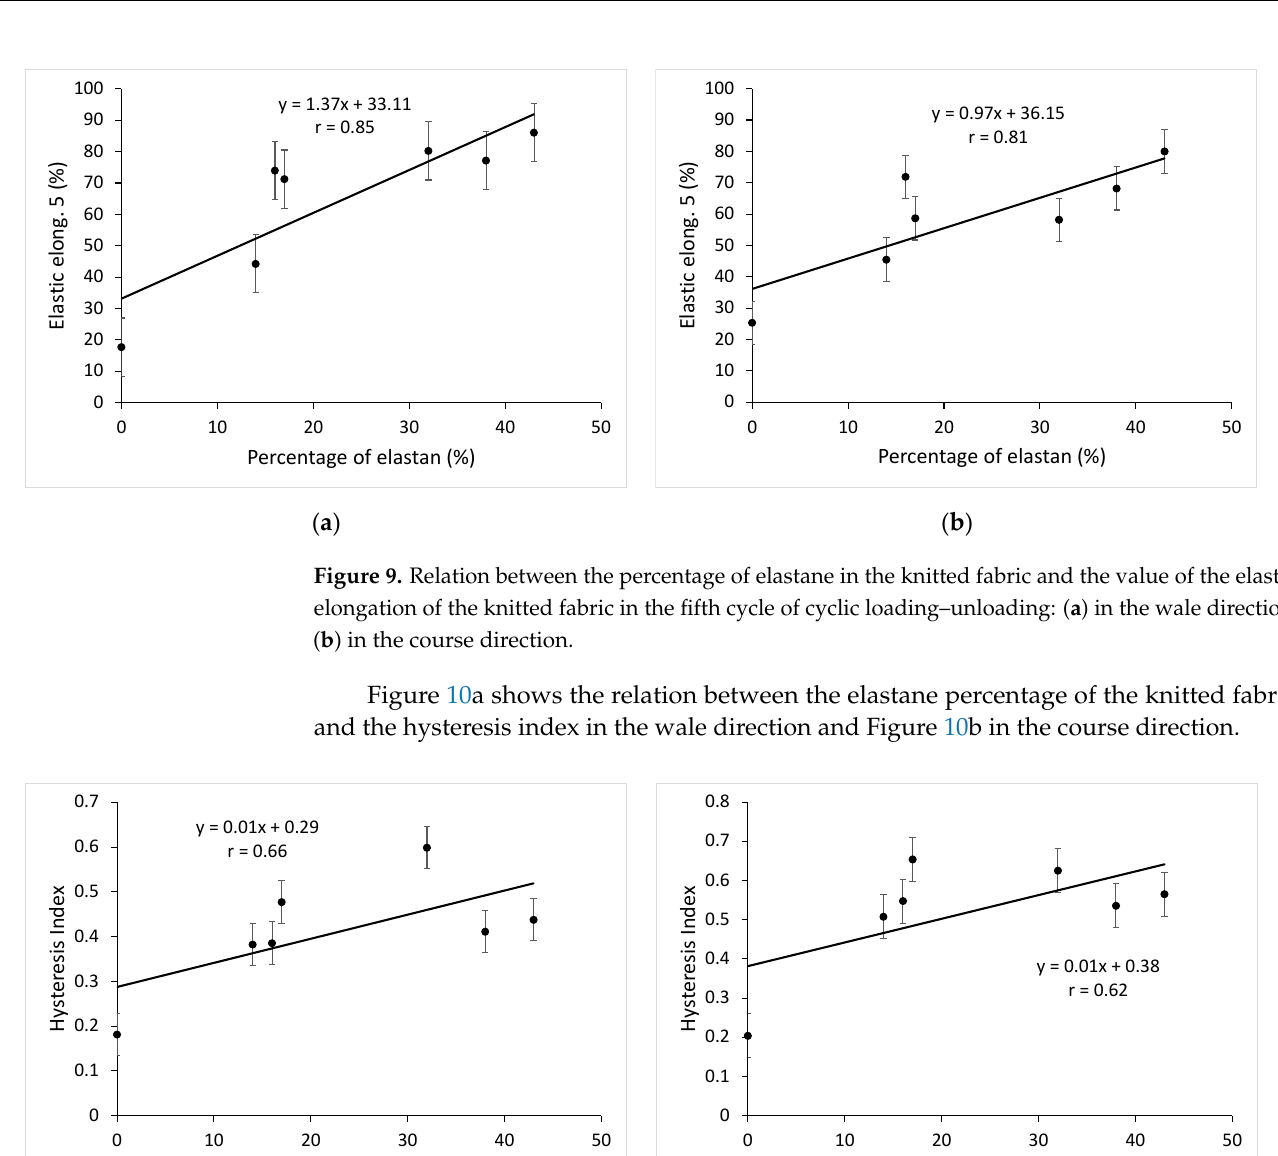
Figure 9. Relation between the percentage of elastane in the knitted fabric and the value of the elastic elongation of the knitted fabric in the fifth cycle of cyclic loading–unloading: ( a ) in the wale direction; ( b ) in the course direction.